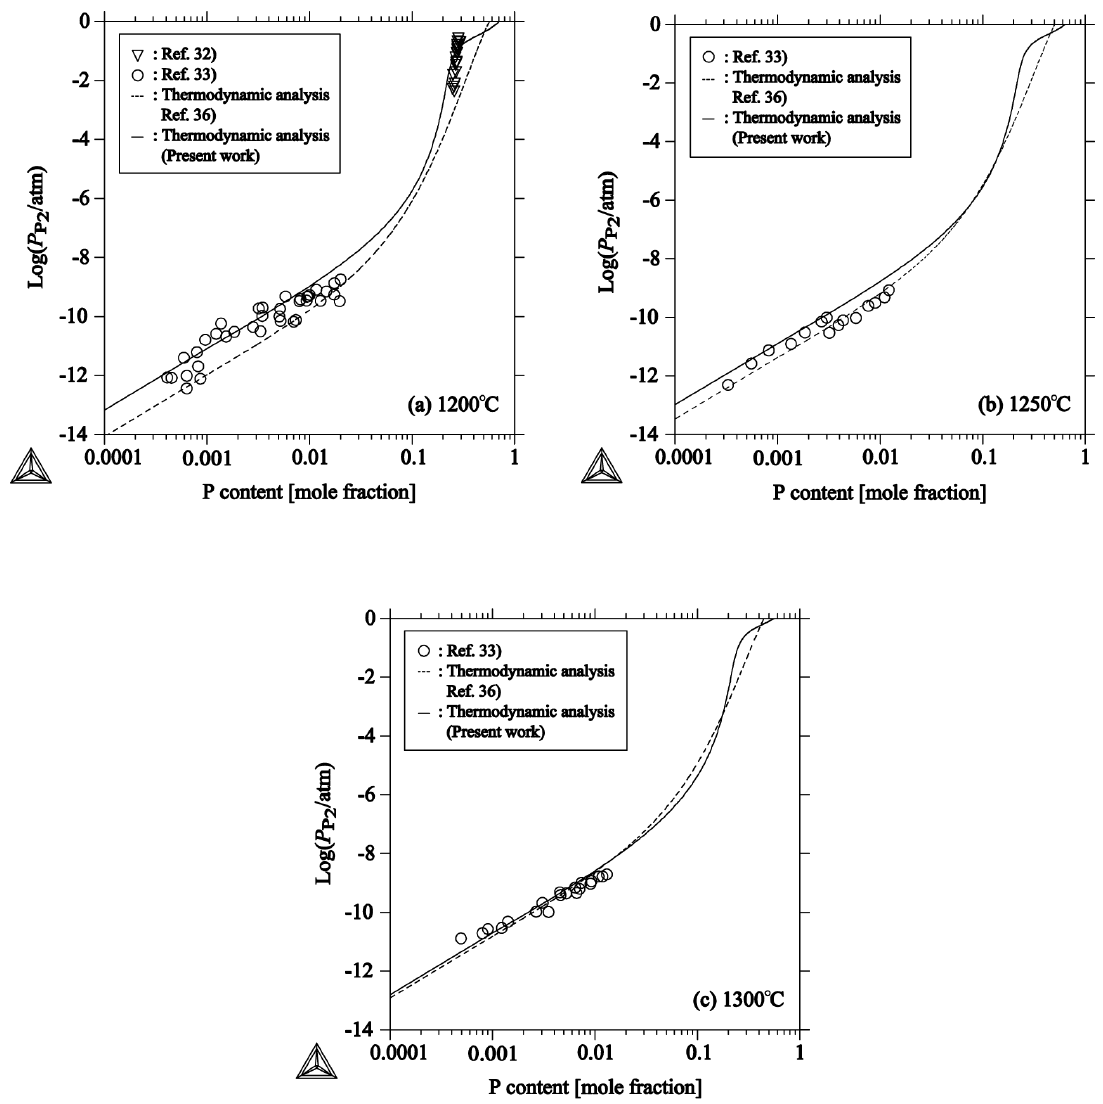
Figure 3. Comparison of calculated and experimental equilibrium partial pressures of P in the liquid Cu-P alloys at